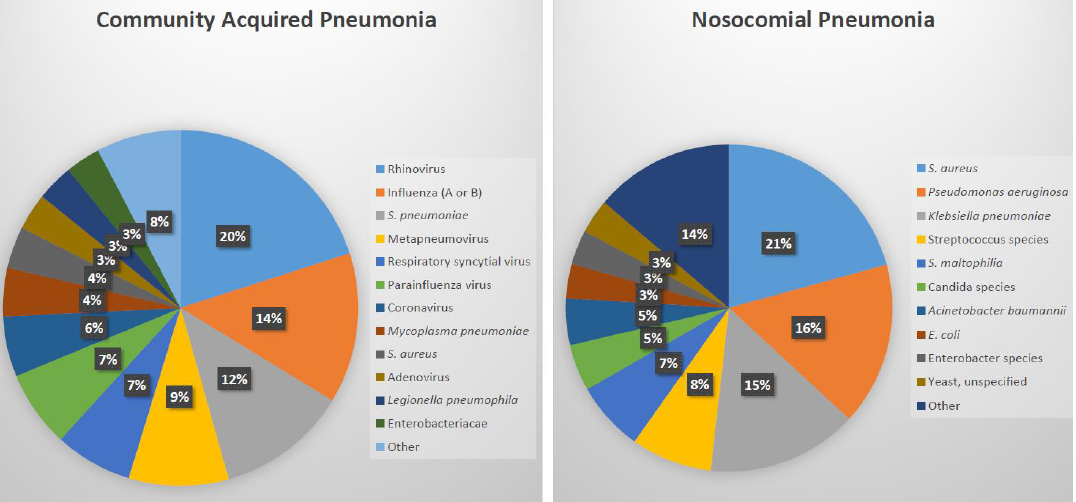
Figure 1. Identified pathogens in community acquired pneumonia (n = 966 pathogens in 853 adults) and nosocomial pneumonia (n = 87) [6,10].